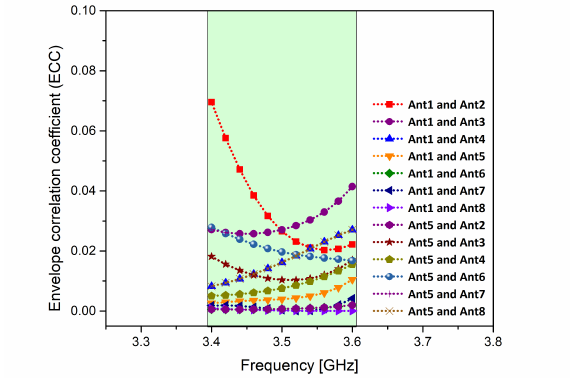
Figure 8. Envelope correlation coefficient (ECC) of the proposed MIMO antenna